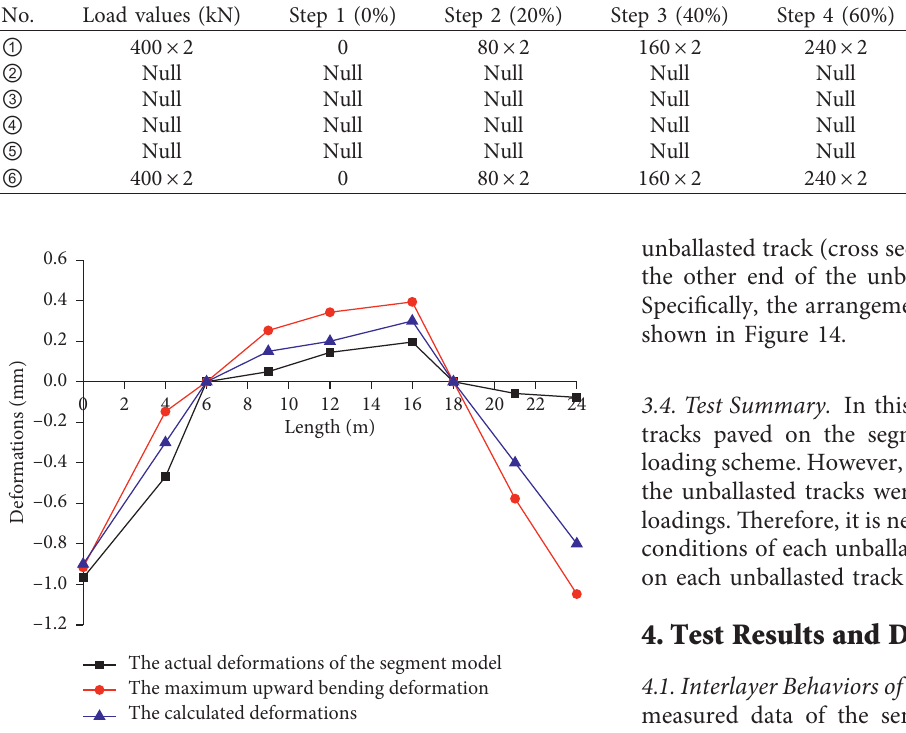
Figure 12: Deformation curves of the maximum upward bending deformation